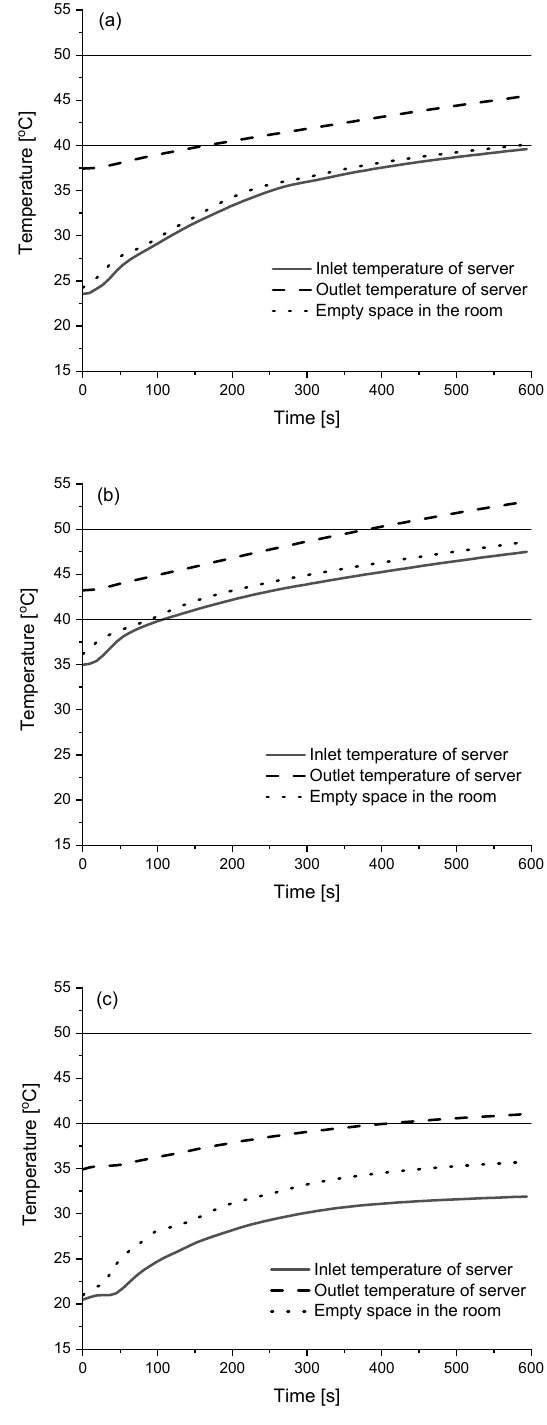
Figure 6. Failure analysis: ( a ) baseline model; ( b ) ECM #1; ( c ) ECMs #2.1 and #2.2.